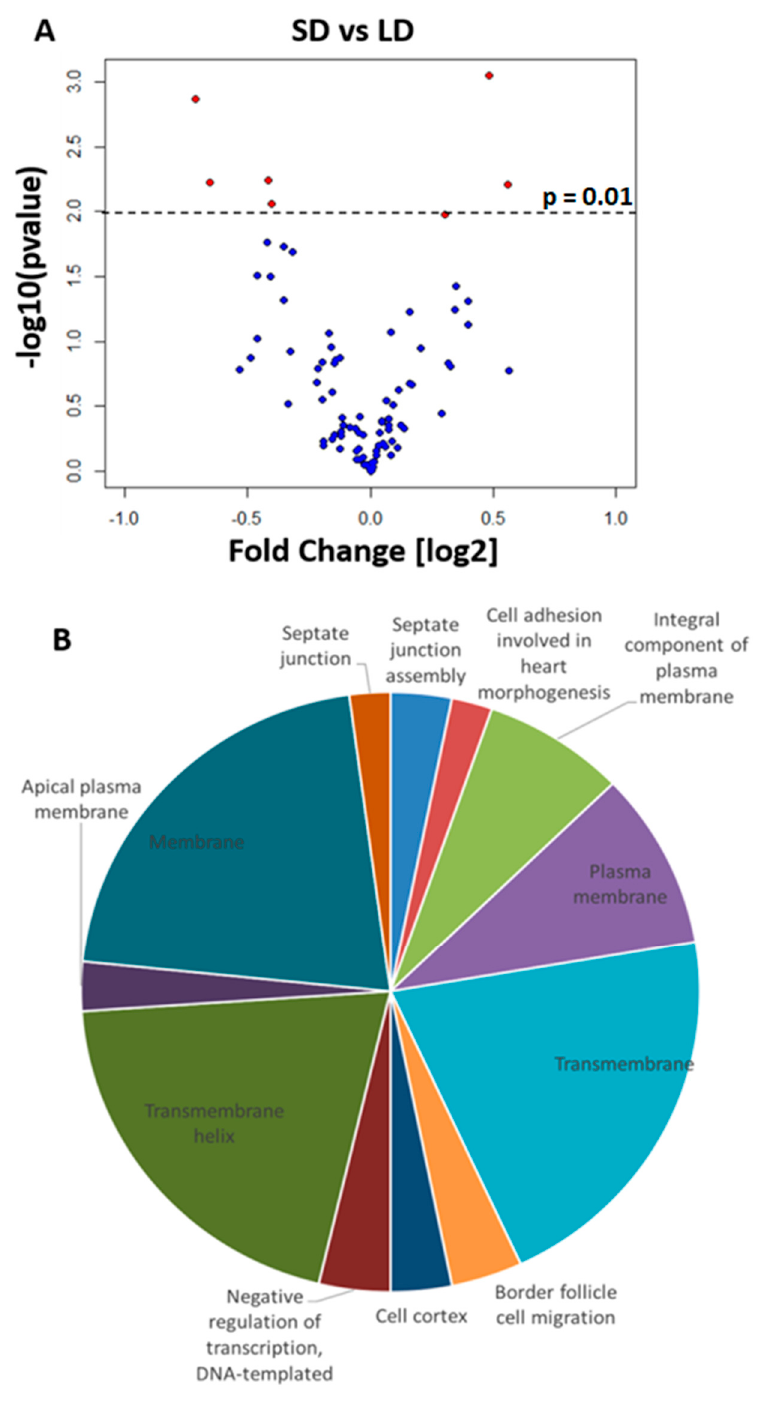
Figure 2. Differences in miRNA expression. ( A) Volcano plot showing differentially expressed miRNA in female heads ( p < 0.01, red; dme - mir184* p = 0.0104) exposed to long-day (LD) and short- day (SD) conditions. Positive fold changes indicate upregulation in short-day readings. ( B ) Pie chart showing enriched biological functions (DAVID, Benjamini p < 0.05) of the 20 most probable targets for each DEM. The size of the pie section is proportional to the number of genes for that biological function. SD: short day. LD: long day.